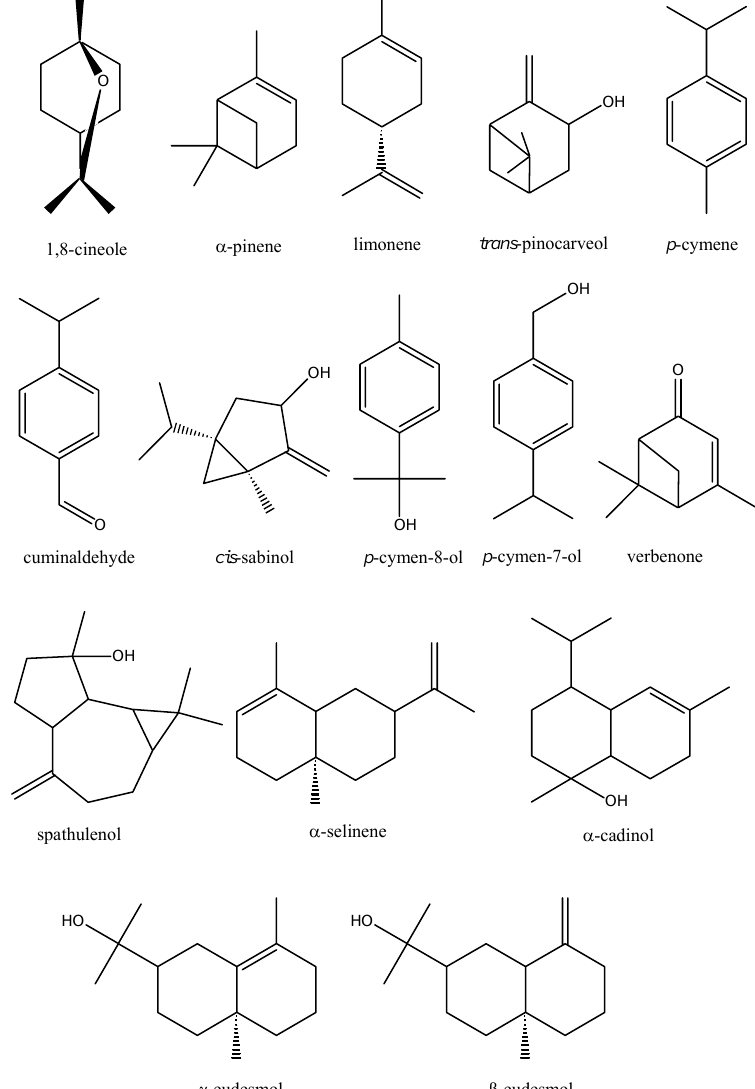
Figure 1. Structures of the most abundant compounds identified in E. oleosa essential oils